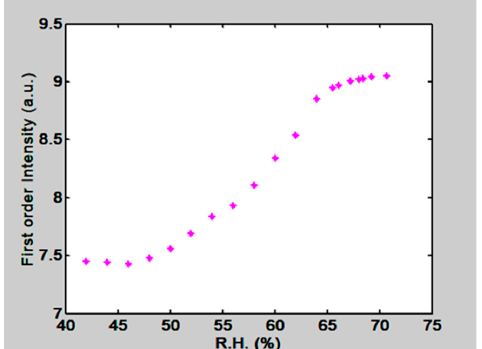
Figure 20. First order intensity as a function of RH in the climatic chamber. A PVA/PAA film with 50 µm thickness was used.